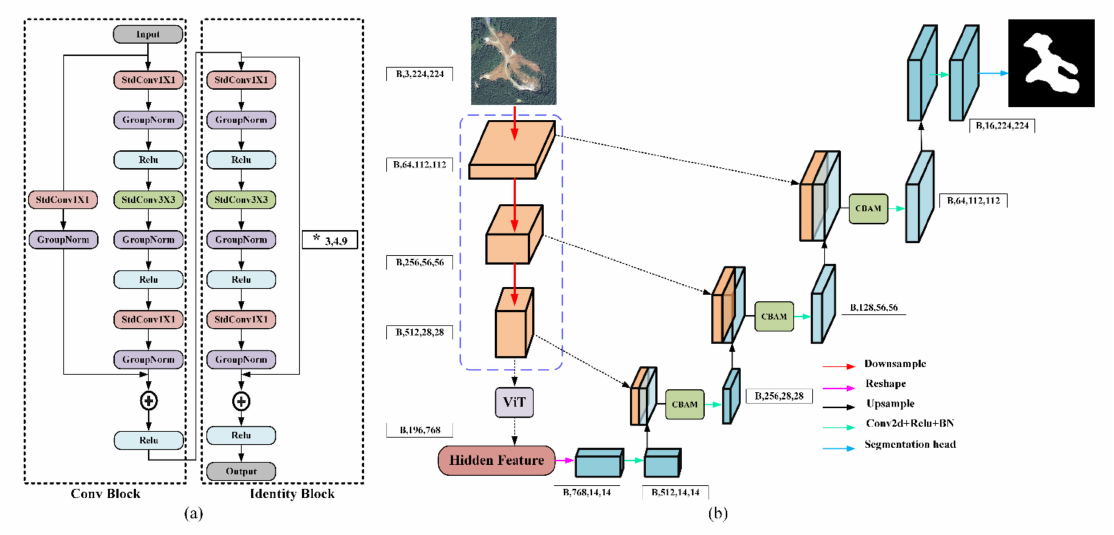
Figure 5. The structure of modified ResNet50 ( a ), CTansUnet ( b ). *3,4,9 represents the cycles of blocks in each stage of